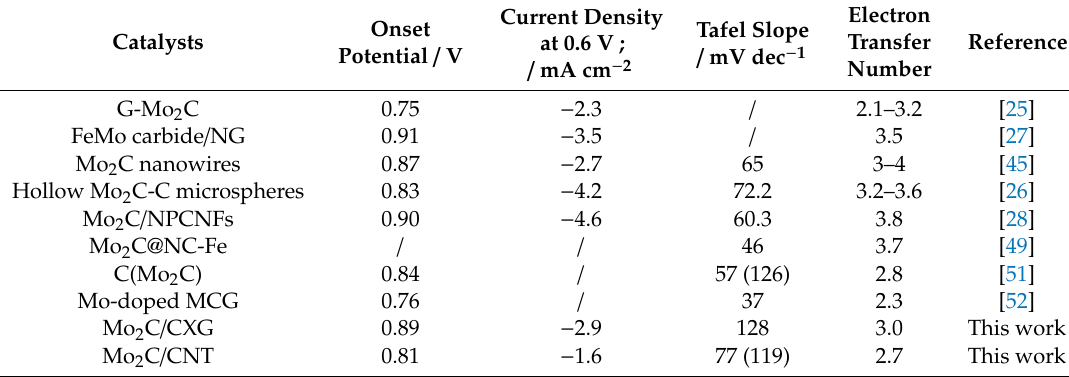
Table 1. Comparison of ORR performance of Mo 2 C / CXG and Mo 2 C / CNT with other reported Mo 2 C-based